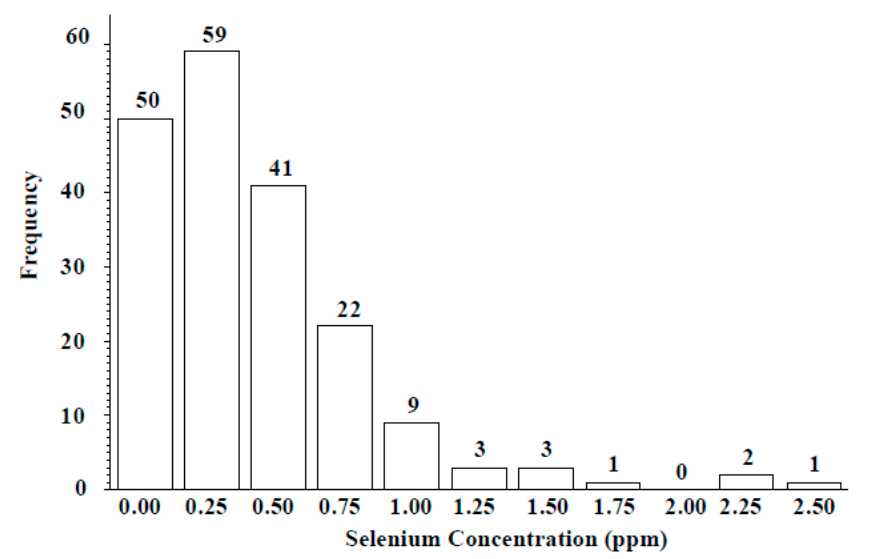
Figure 3. Frequency distribution of seed Se concentration of ICARDA lentil wild accessions grown in Lebanon.